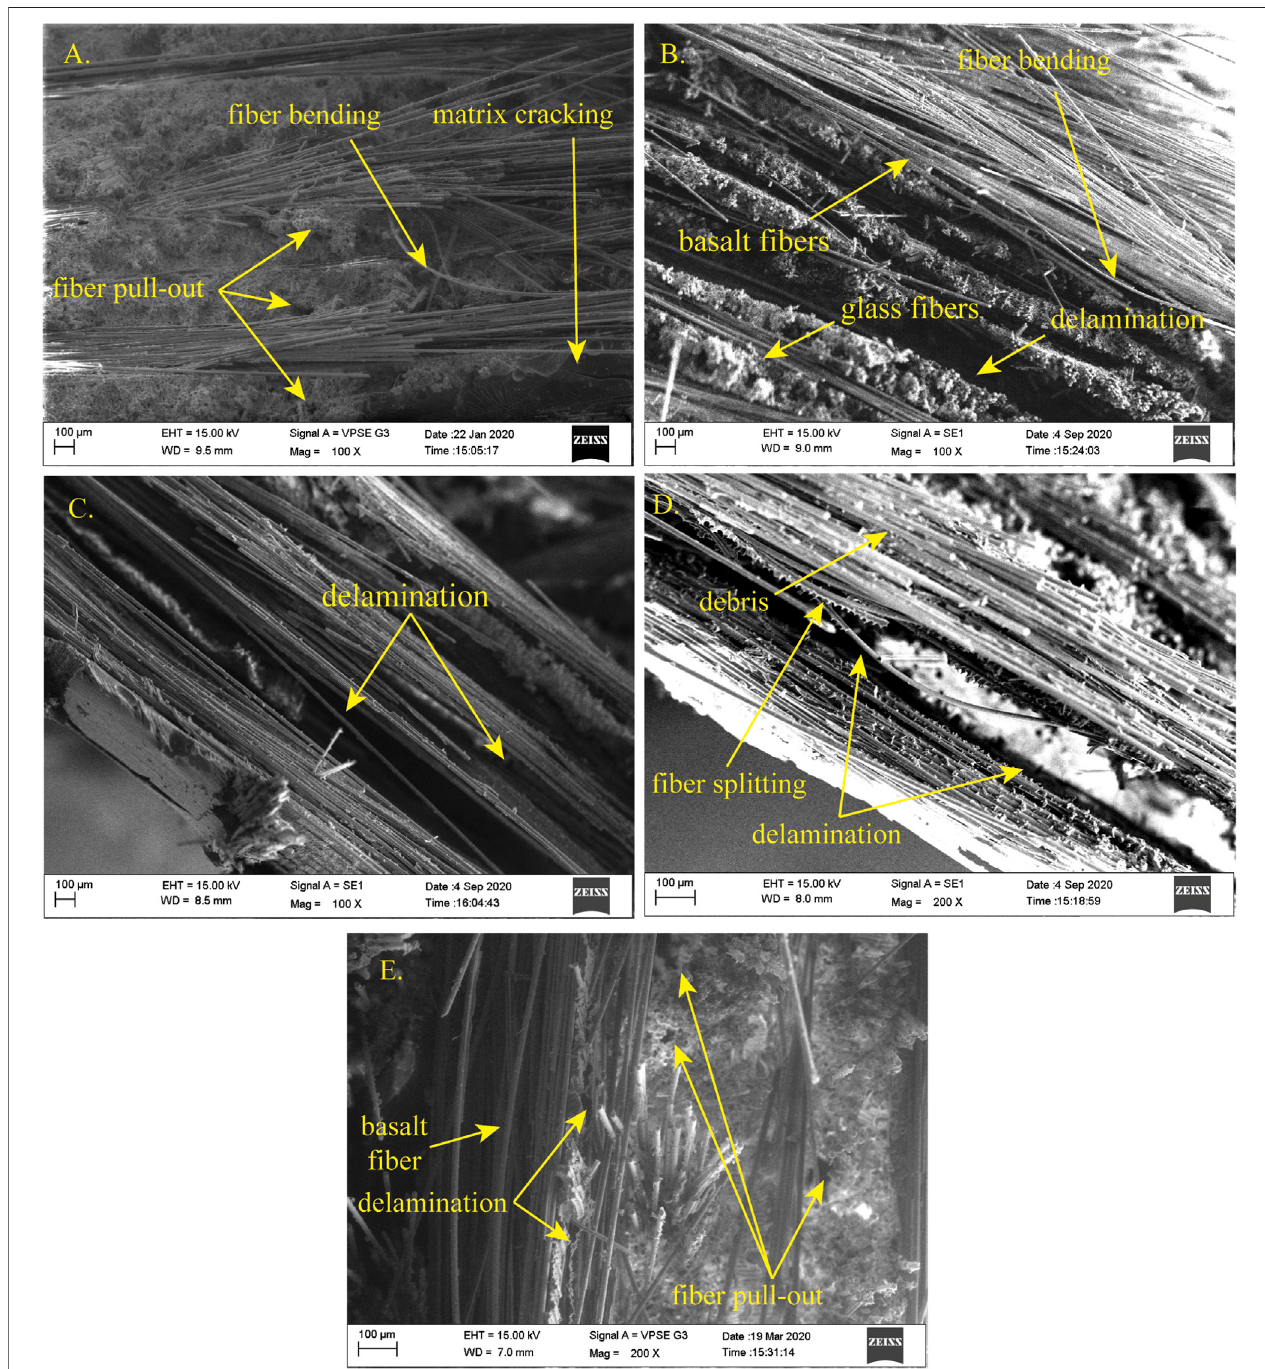
FIGURE 6 | SEM micrographs for tensile specimens. (A) EGC, (B) HGB, (C) MEG, (D) MEB, (E) MHC.